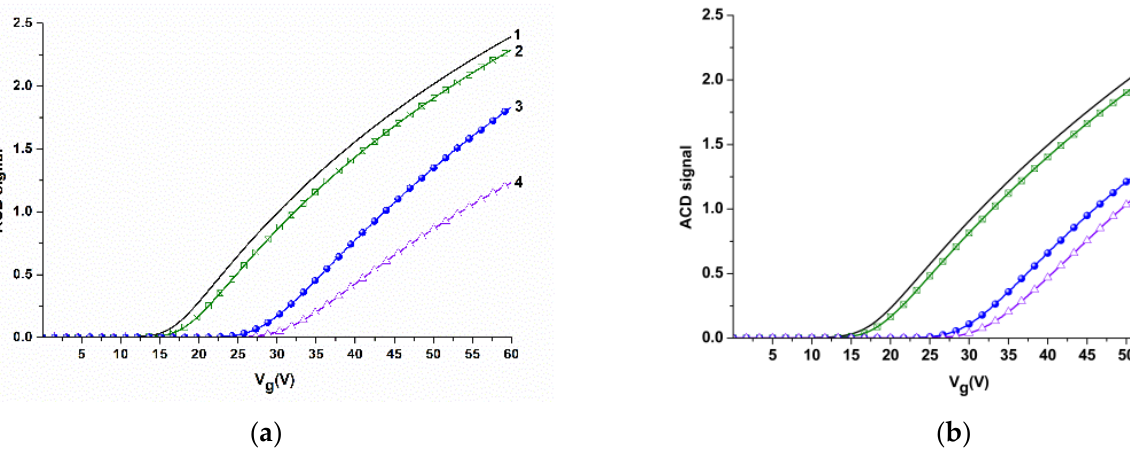
Figure 4. Volt-ampere characteristics obtained for NR sensors before and after their sensitization with molecular probes in air, in water, and in potassium phosphate buffer for NR#6 (with immobilized antibodies against influenza A virus) ( a ), and for NR#2 (with immobilized antibodies against HBsAg) ( b ). Experimental conditions: 1 mM potassium phosphate buffer, pH 7.4, V g 0 ÷ 60 V, V ds 0.1 V, liquid volume in the cell 300 µ L. Black line (1) indicates volt-ampere characteristics (VAC) curves obtained for silanized NRs in air; green line (2) indicates VAC curves obtained for NR sensors with immobilized antibodies in air; blue line (3) indicates VAC curves obtained for NR sensors with immobilized antibodies in water; magenta line (4) indicates VAC curves obtained for NR sensors with immobilized antibodies in potassium phosphate buffer.